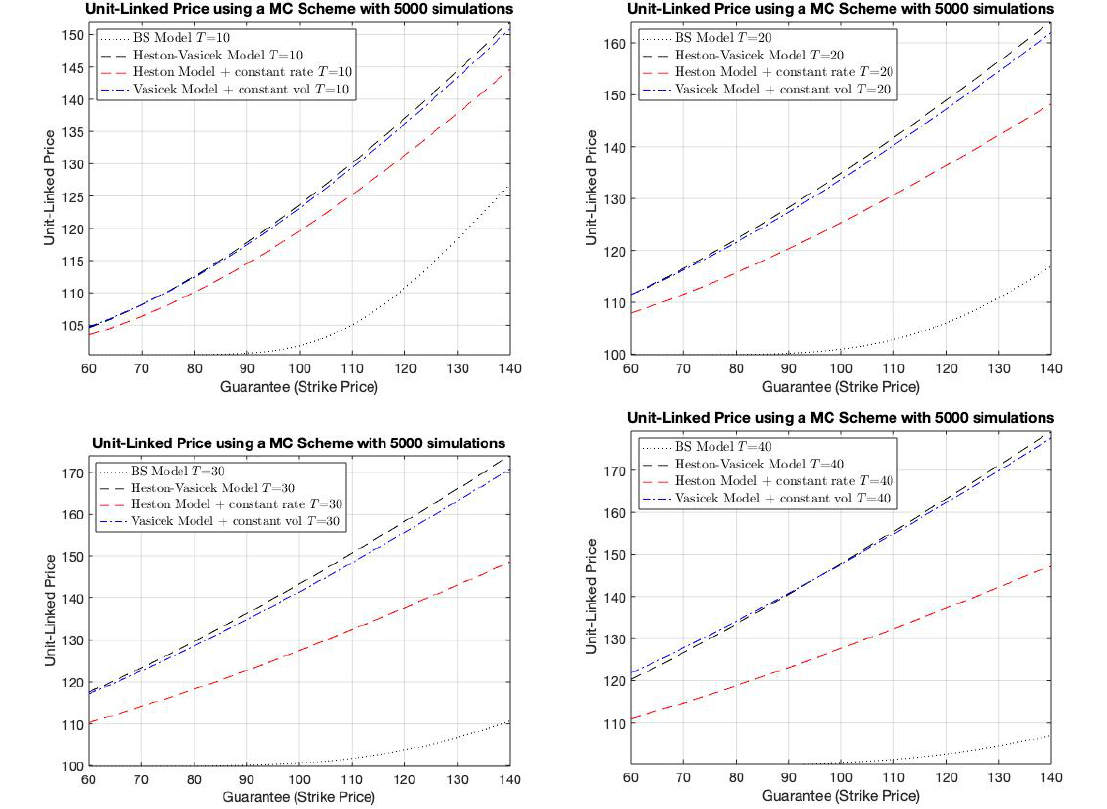
Figure 1. Pricing comparative between the Black-Scholes model, Vasicek-Heston model written in forward variance, Heston model with constant rate r 0 , and a Vasicek model with constant volatility ν 0 for T ∈ { 10,20,30,40 }